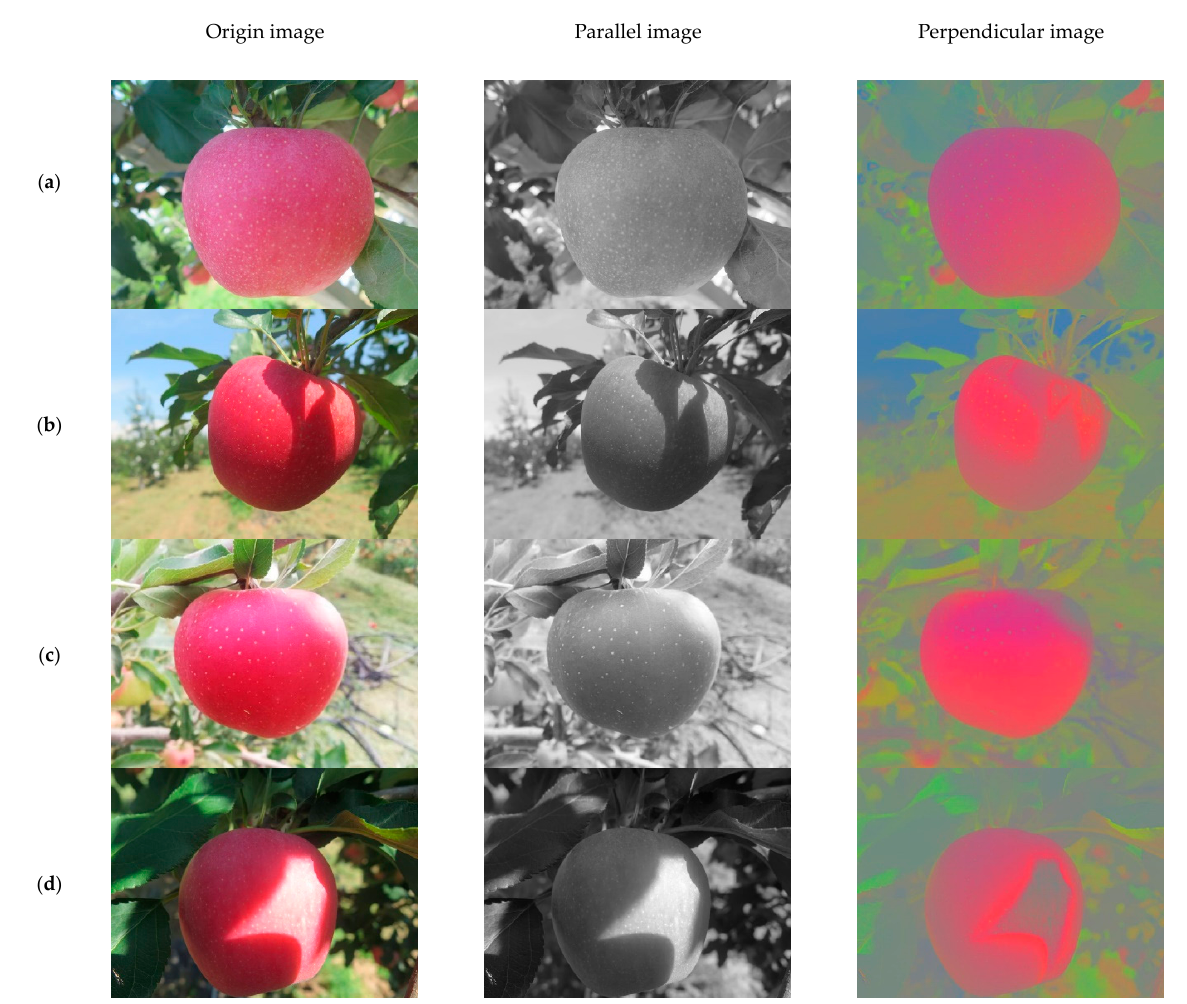
Figure 3. Results of quaternion decomposition for four images of the apple dataset: ( a ) without any intense light irradiation and without any shadow, ( b ) with shadows but without any intense light irradiation, ( c ) with intense light irradiation but without any shadow, ( d ) with both shadows and intense light irradiation.